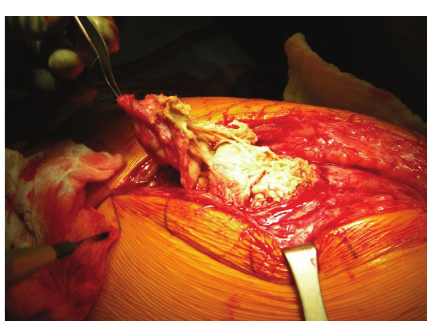
Figure 4: Revision surgery.